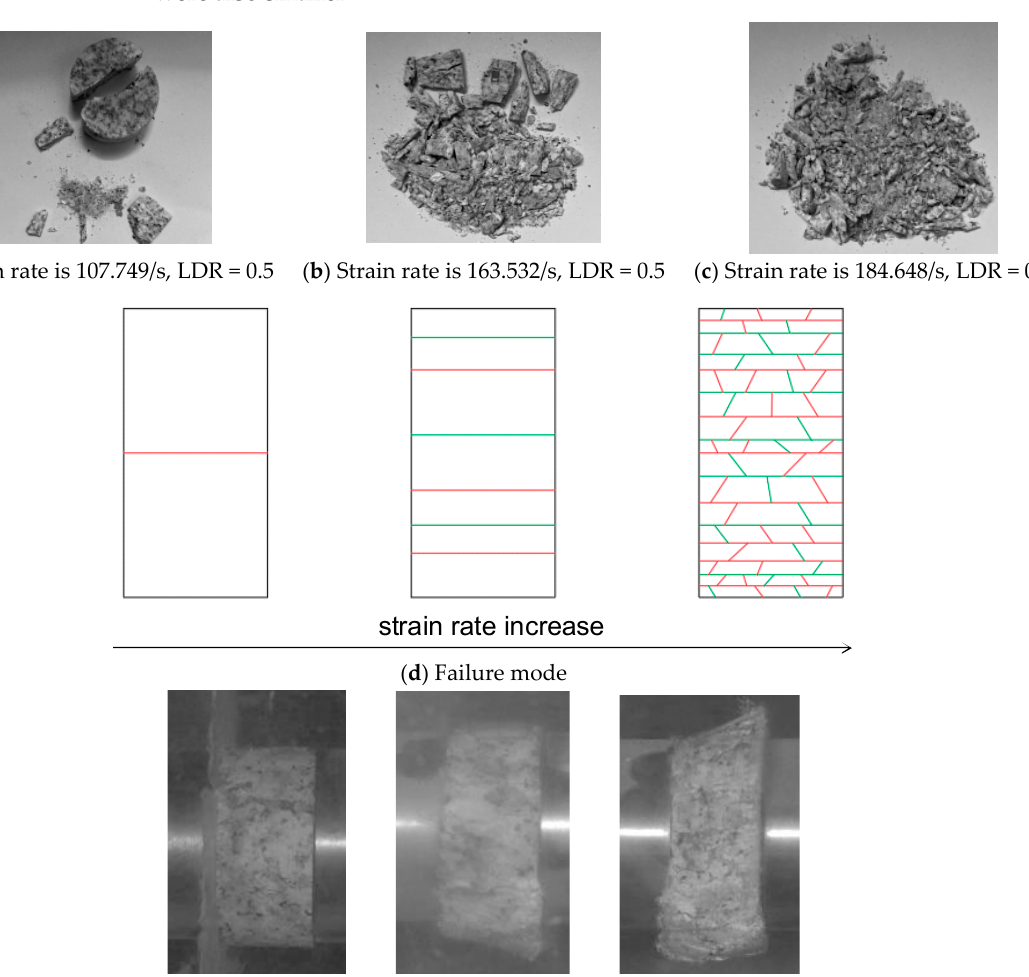
Figure 5. Influence of strain rate on specimen crushing.